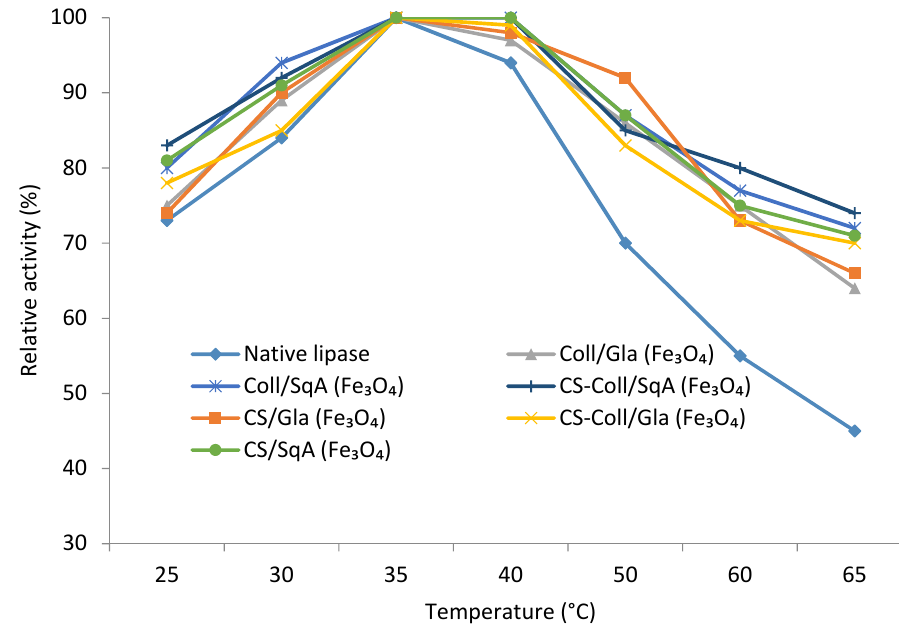
Figure 7. Effect of temperature on lipase